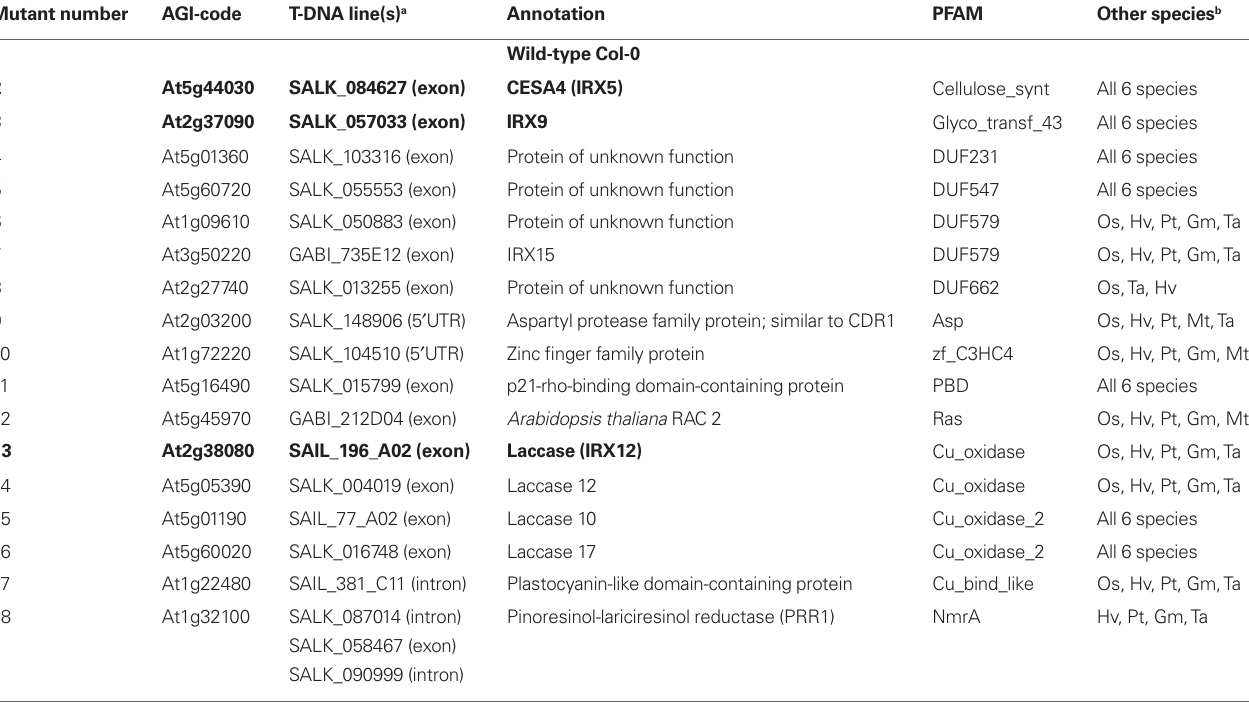
a All lines are in Col-0 background. b The respective co-expression networks of the Arabidopsis CESA7 homologs of rice (Os), poplar (Pt), barley (Hv), soybean (Gm), medicago (Mt), and wheat (Ta) contained at least one homolog of the respective gene. Bold indicates known genotypes, and corresponding secondary wall phenotypes.